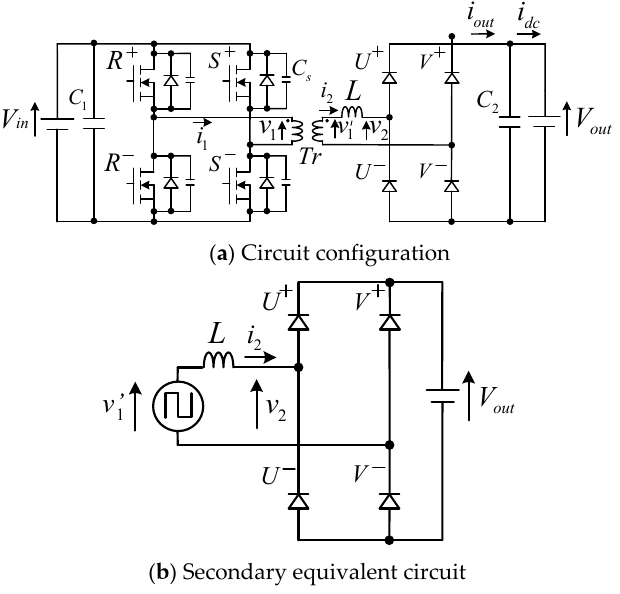
Figure 2. Conventional SAB DC–DC converter.